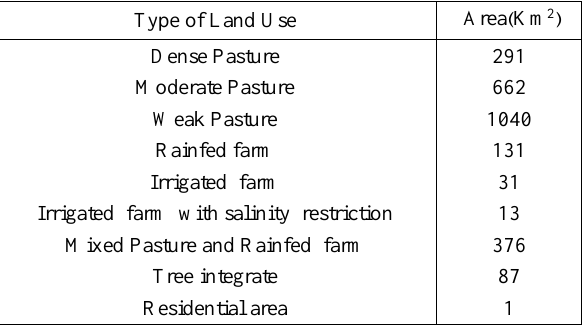
Table 3. Land uses in Zilberchai